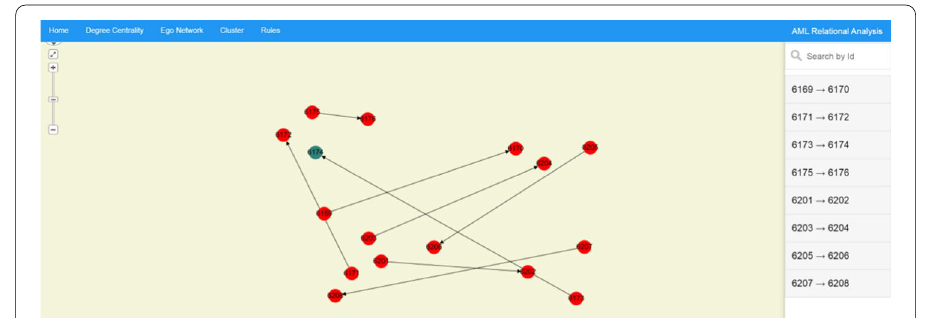
Fig. 14 Rule 6: SameAs